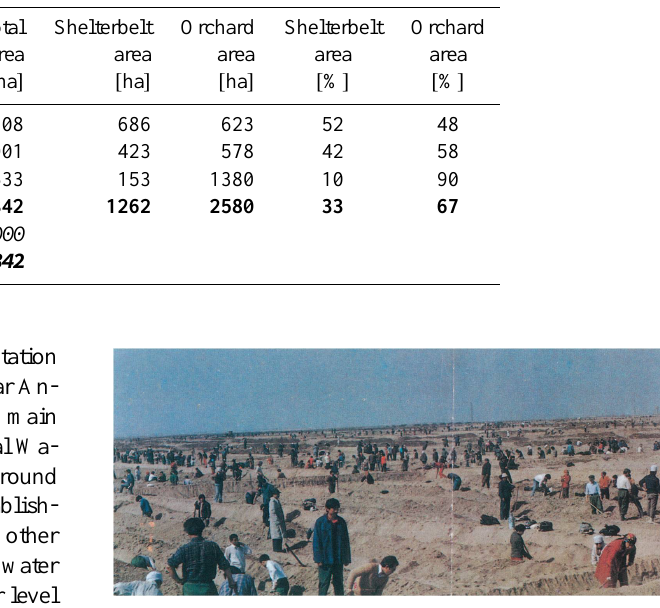
Figure 4. Compulsory labour on the Kökyar fields (adapted from Kökyar Annals Compilation Committee,